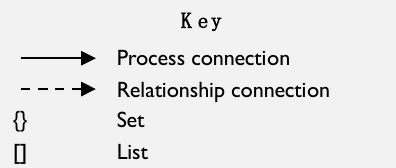
Figure A3. Connector patterns.